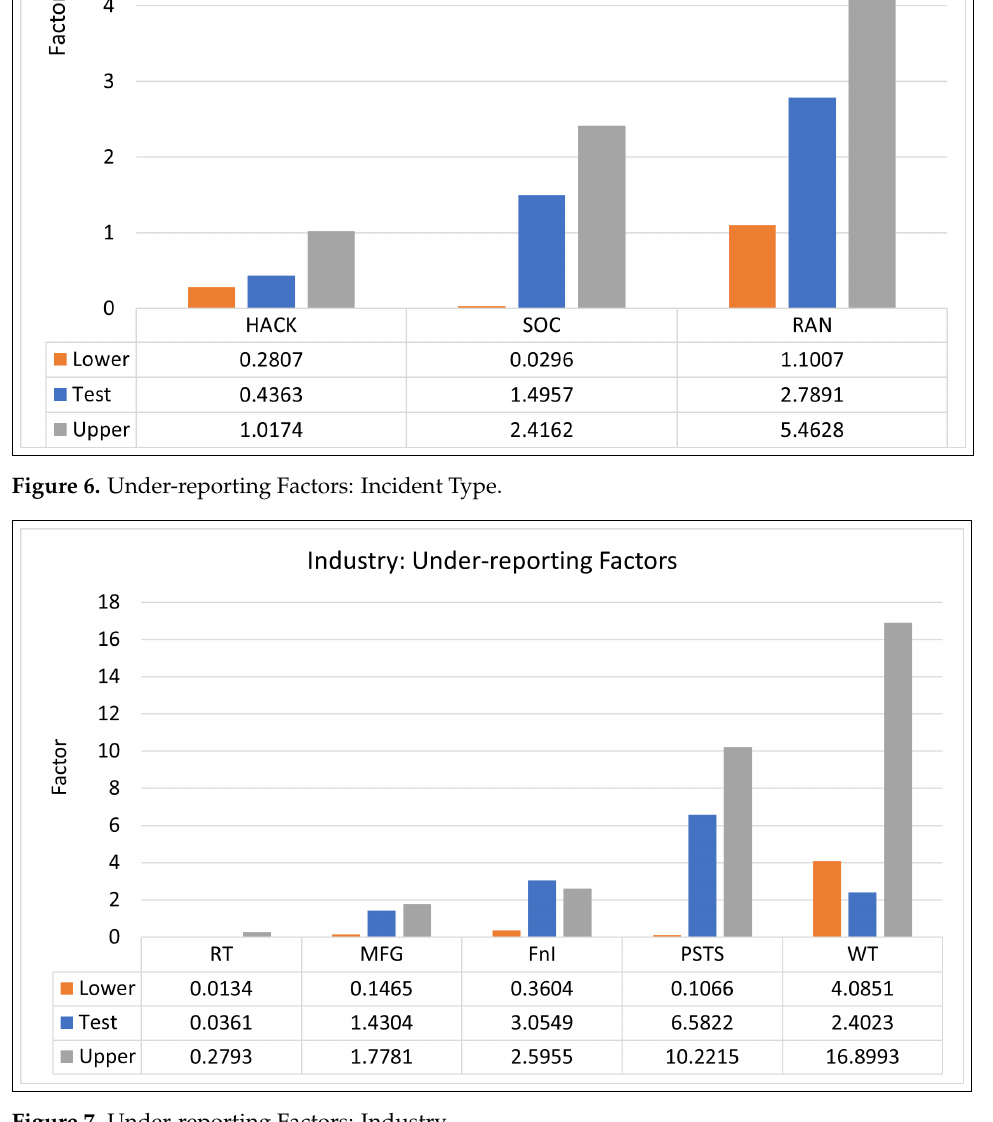
Figure 7. Under-reporting Factors: